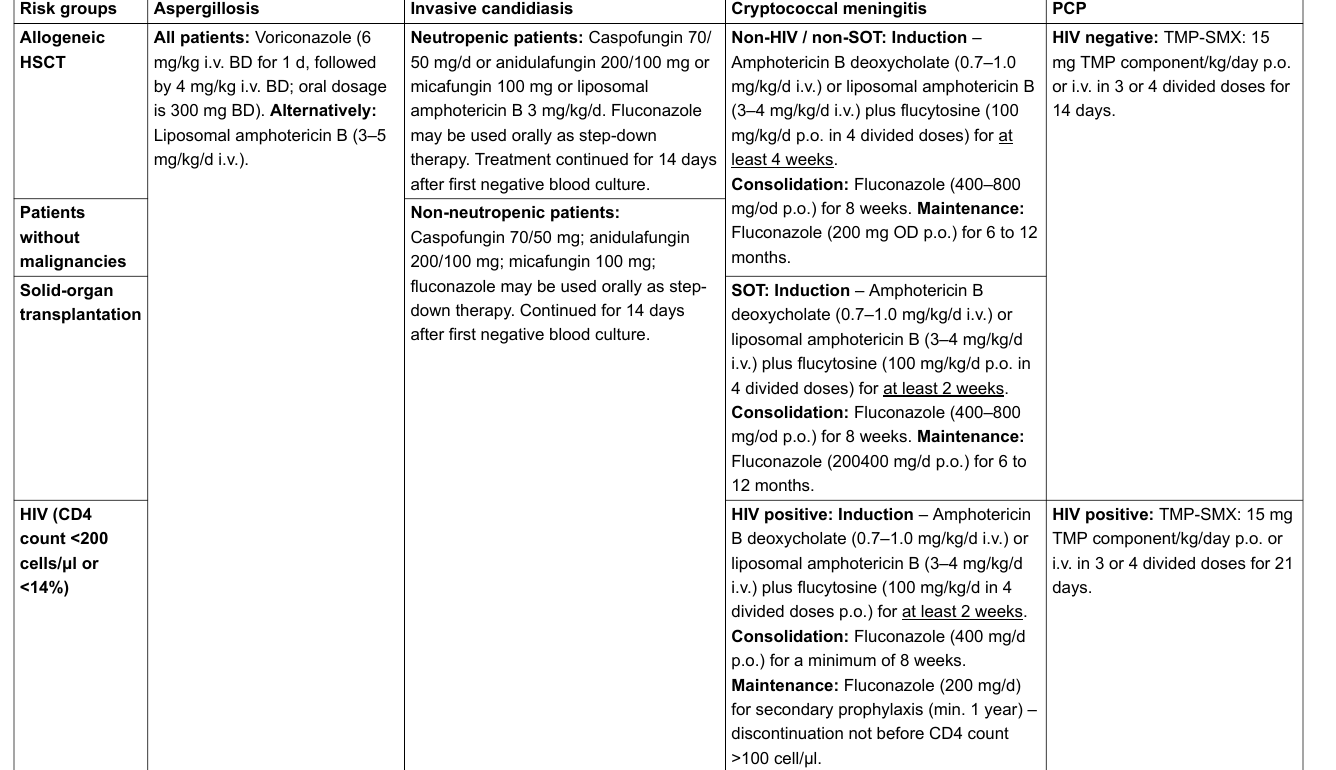
Table 2: Therapeutic regiments with grade A1 recommendation for invasive candidiasis, aspergillosis, cryptococcal meningitis and Pneumocystis jirovecii pneumonia (PCP). Risk